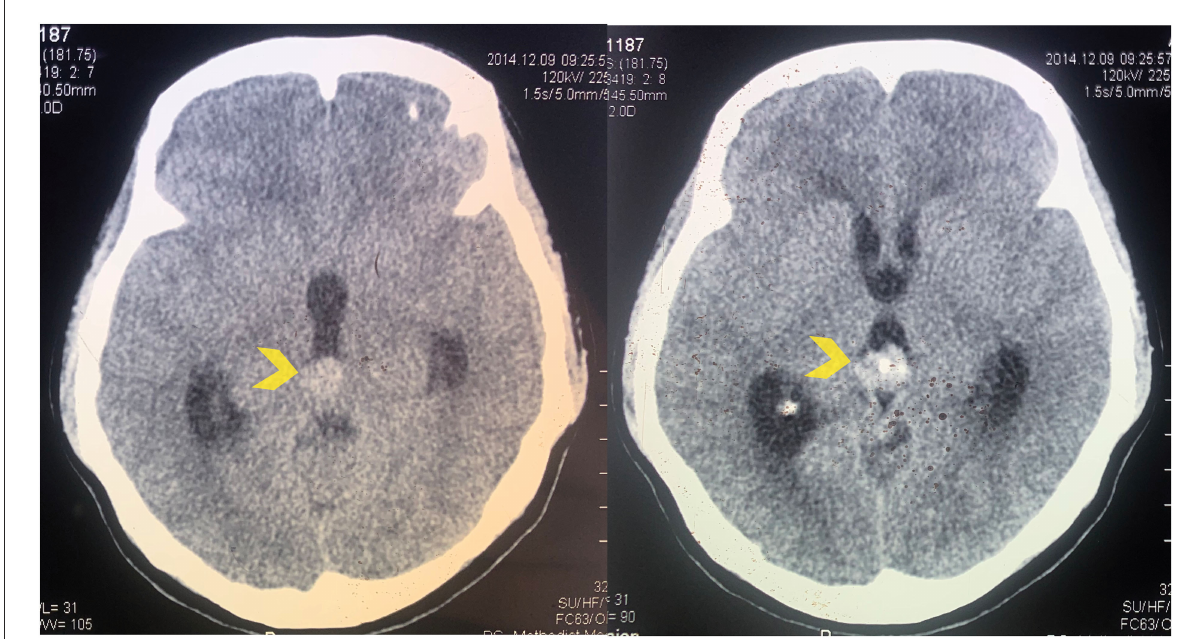
FIGURE1 Axial CT scan without contrast showing the pineal region tumor at the time of the initial diagnosis in 2014 (yellow arrowhead).